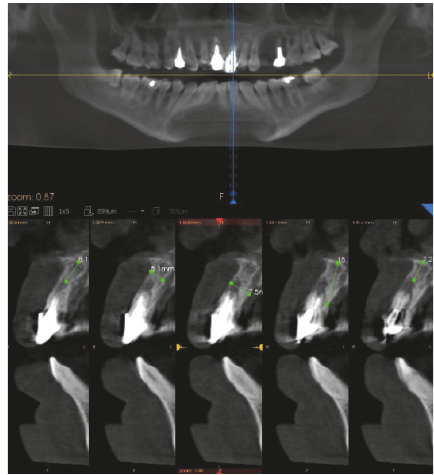
Figure 2: Cone beam computed tomography (CBCT). The cone beam computed tomography (CBCT) examination confirms the presence of the tooth resorption. A careful 3D analysis of the height and width of the alveolar ridge is performed, in order to better plan the implant